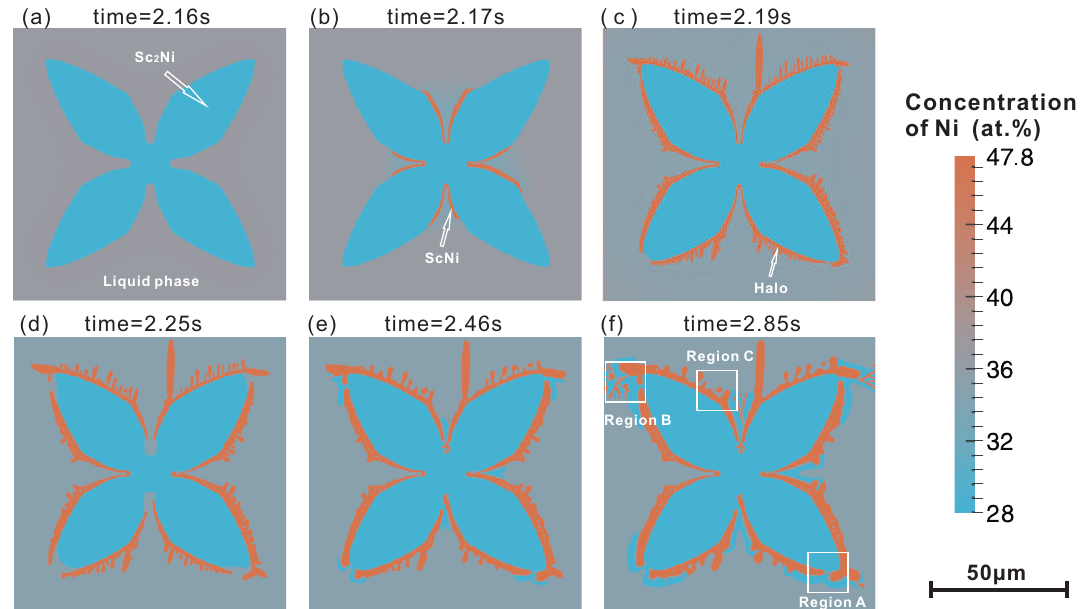
Figure 3. Phase-field simulated microstructure of the Sc-34 at % Ni binary alloy during solidification at different time slides: ( a ) 2.16 s; ( b ) 2.17 s; ( c ) 2.19 s; ( d ) 2.25 s; ( e ) 2.46 s; ( f ) 2.85